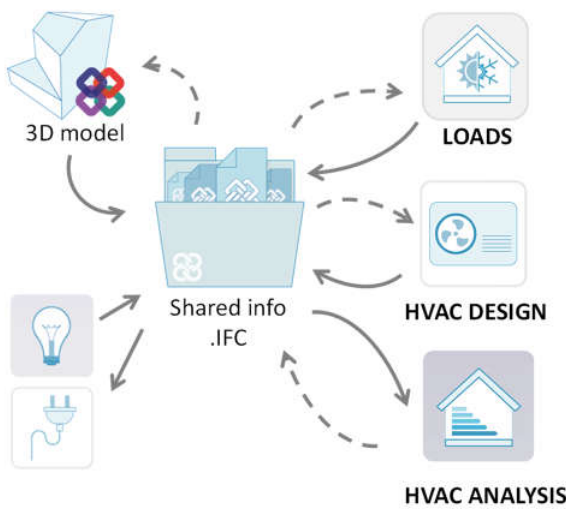
Figure 4. Open business information modelling (BIM) workflow.